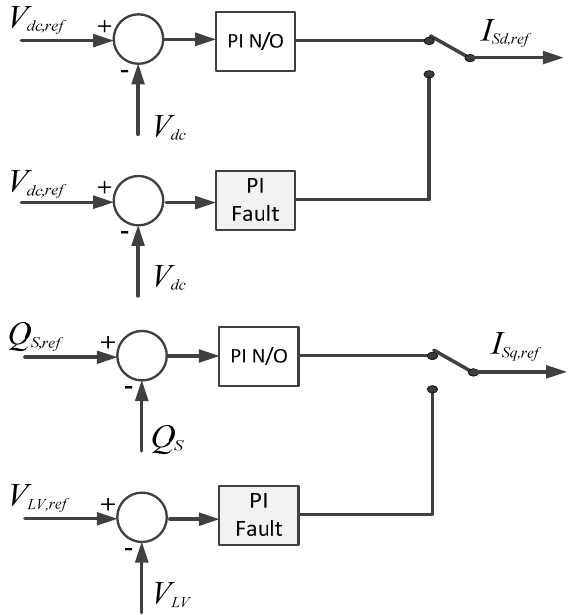
Figure 14. Block diagram of the outer control technique implemented in the STATCOM. ( N/O = normal operation, Fault = fault